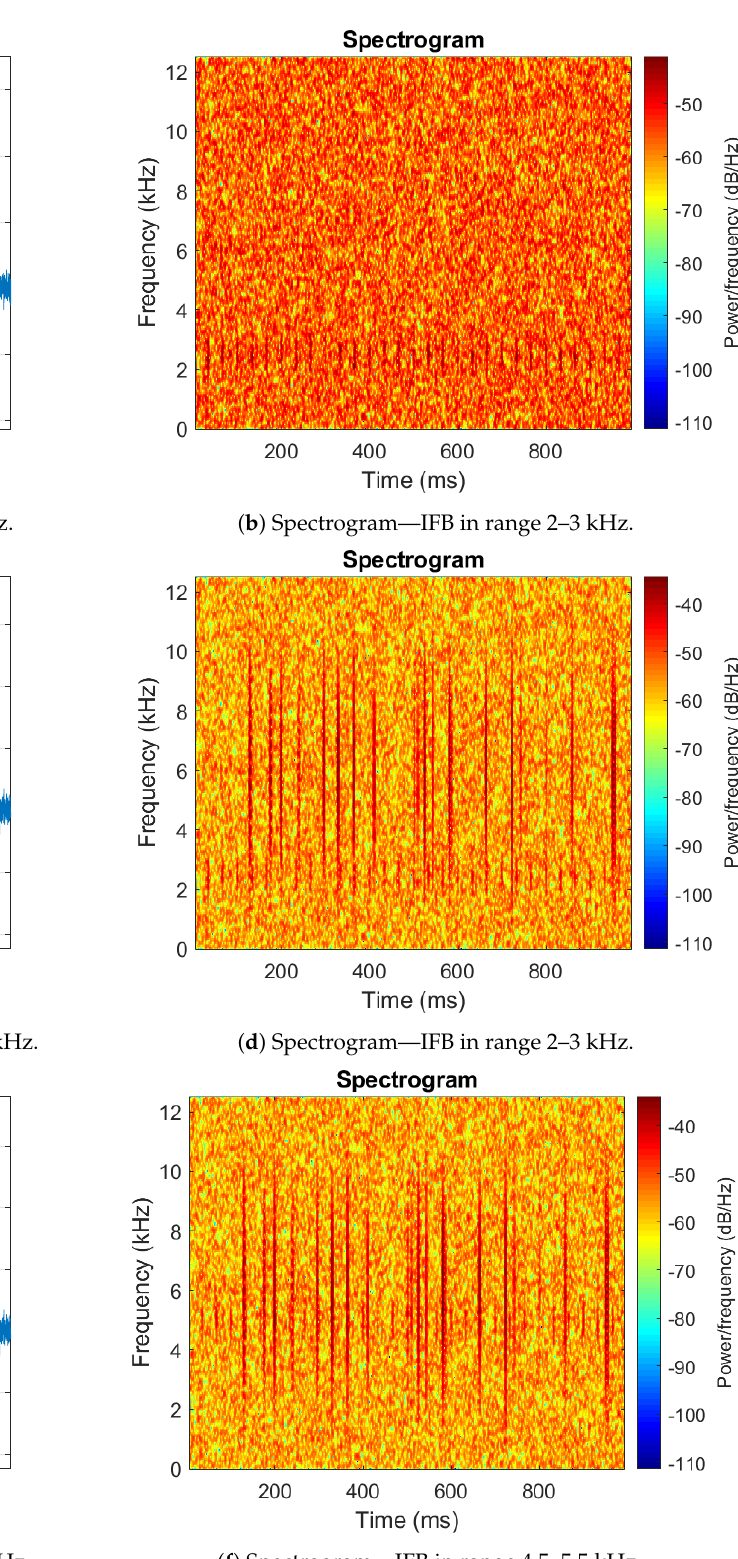
Figure 1. Vibration signal and its spectrogram for Gaussian signal with a local fault ( a , b ) and a heavy-tailed signal with a local fault, with a different carrier frequency of fault: 2.5 kHz ( c , d ) and 5 kHz ( e , f ), carrier frequency of non-cyclic: 6